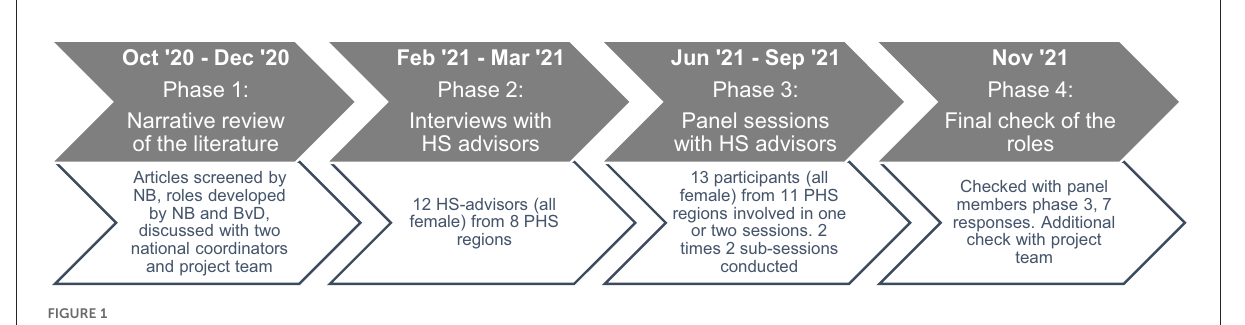
FIGURE1 Phases of the current